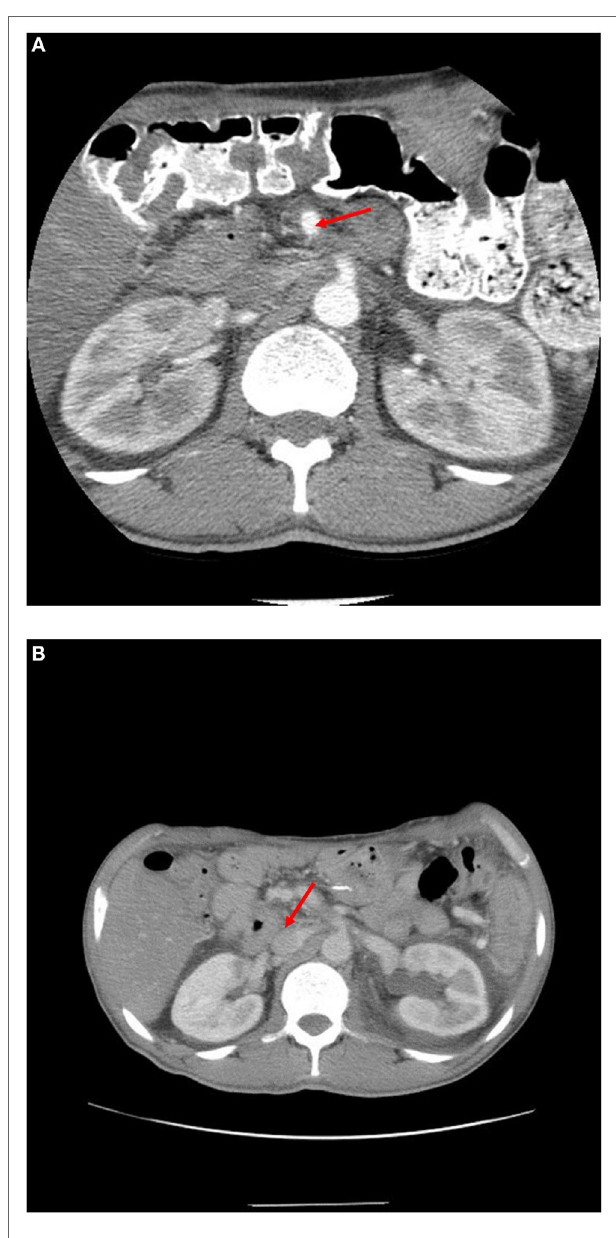
FIgURe 4 | (a) 1 year post-operative scan showing SMA (see arrow) is clear of disease. (B) 7 year post-operative scan showing renal vein at IVC (see arrow) widely patient and without disease.